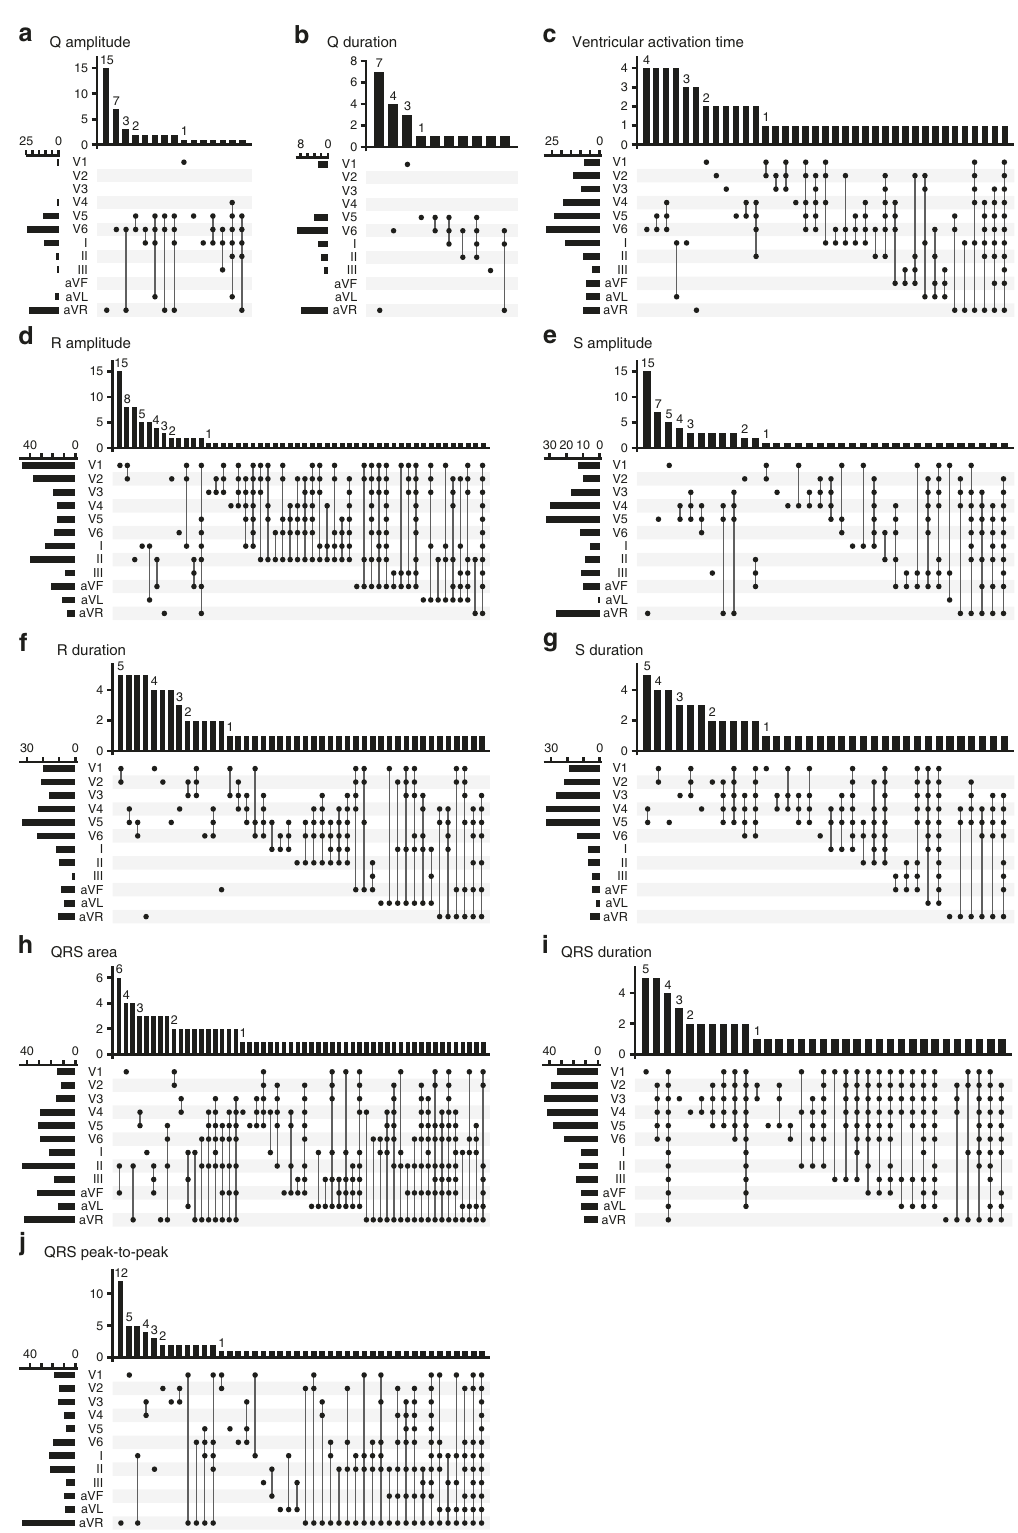
Fig. 2 Intersection plots of associations for the QRS measures. In each panel, the left bar plot shows how many of the 190 QRS variants associate ( P < 5 × 10 − 8 ) with each lead. The top bar plot shows the sizes of intersecting sets of associations for the leads denoted with (connected) black dots. a Q amplitude; b Q duration; c Ventricular activation time; d R amplitude; e S amplitude; f R duration; g S duration; h QRS area; i QRS duration; j QRS peak-to-